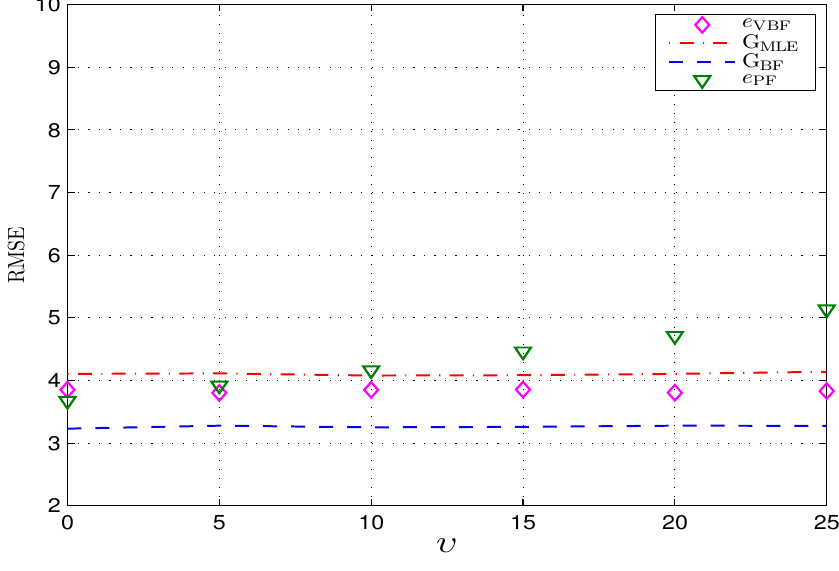
Figure 4. Achieved RMSEs over different movement velocity means. The y -axis is in